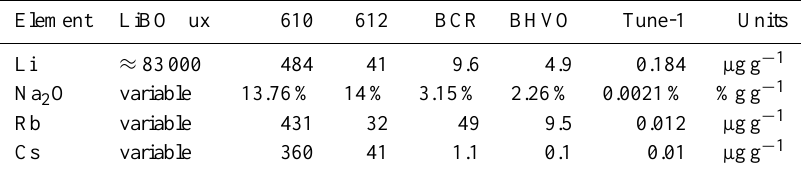
Table 1. Alkali contents of popular natural and synthetic ICPMS reference materials. Li, Rb, Cs in ppm (µgg − 1 ). Na is weight percent oxide. Values from Govindaraju (1994), Eggins et al. (1997), Norman et al. (1998), Hinton (1999), and Gao et al. (2002). LiBO flux Li content is an estimate; exact content depends on tetraborate / metaborate ratio, and rock type fluxed.